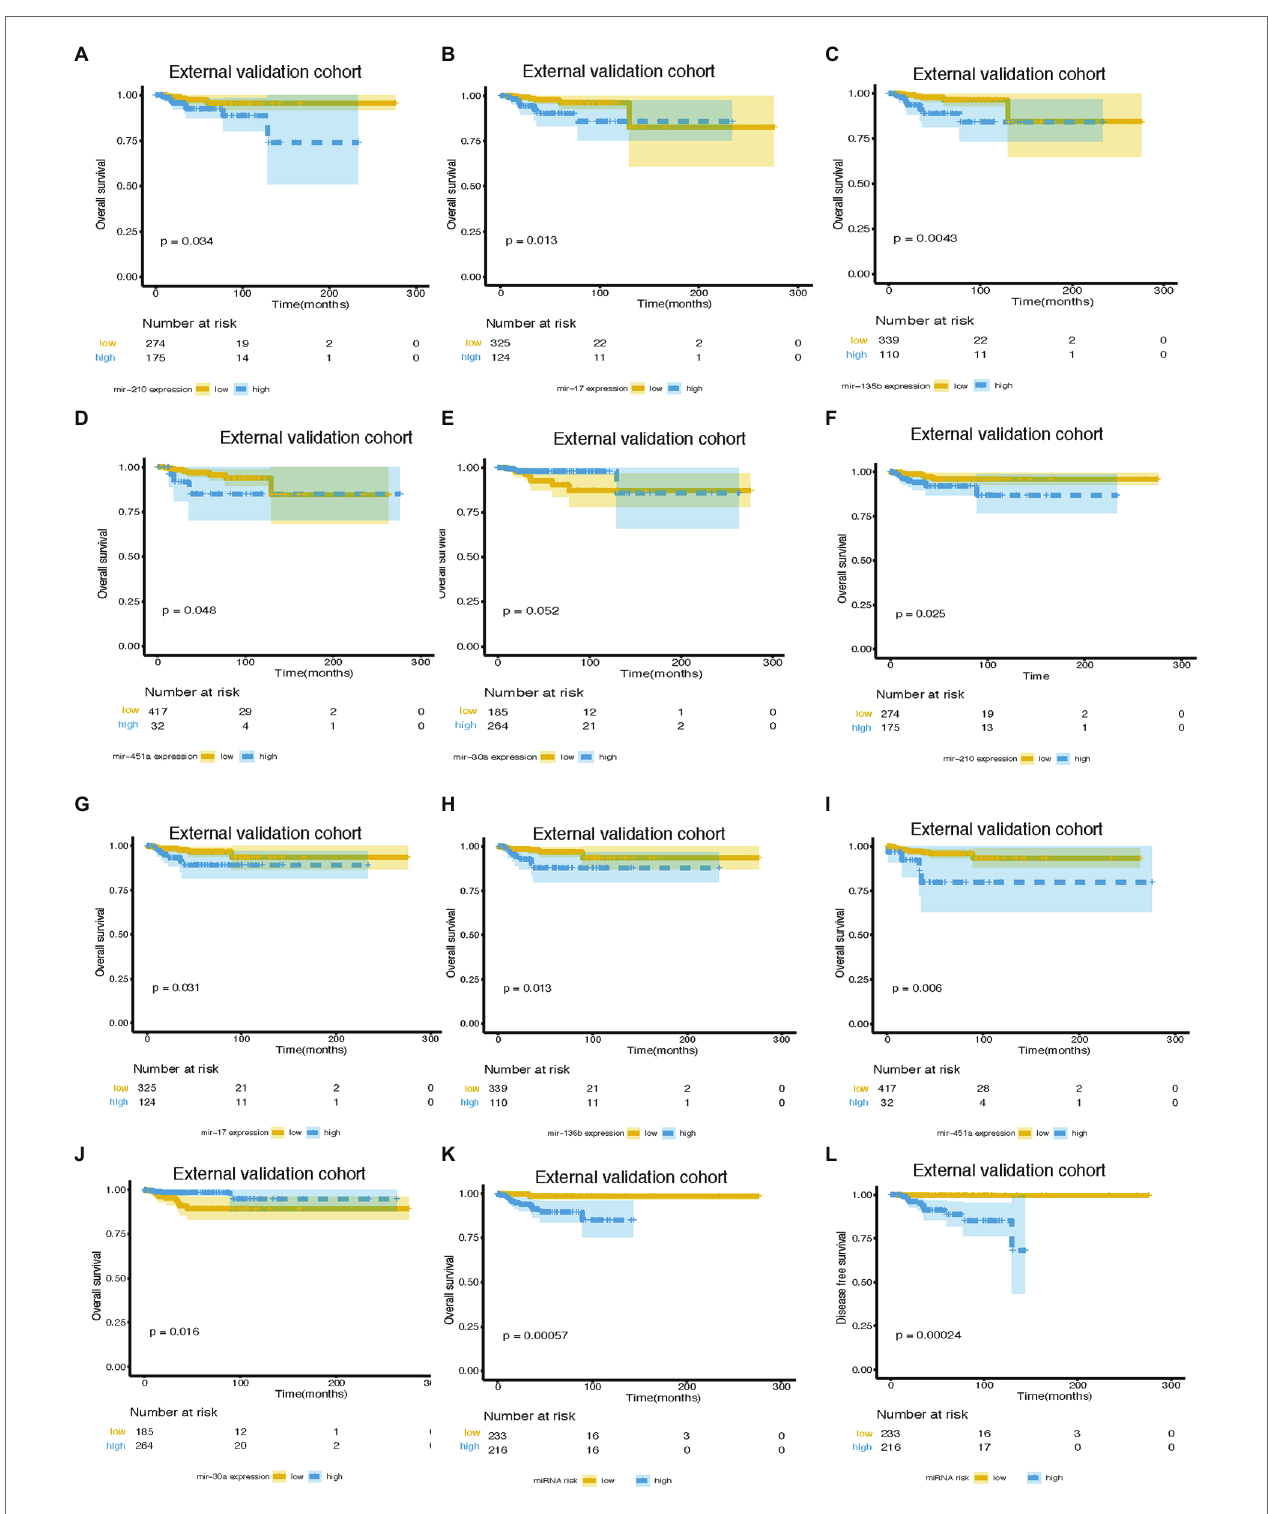
FIGURE 5 | Survival curves of BC patients stratified by different variables. KM curves of overall survival of breast cancer patients stratified by (A) mir-210 expression, (B) mir-17 expression, (C) mir-135b expression, (D) mir-451a expression, (E) mir-30a expression, and (K) miRNA risk score in the external validation cohort. Kaplan-Meier curves of disease-free survival of breast cancer patients stratified by (F) mir-210 expression, (G) mir-17 expression, (H) mir-135b expression, (I) mir-451a expression, (J) mir-30a expression, and (L) miRNA risk score in the external validation cohort. miRNA, microRNA; BC, breast